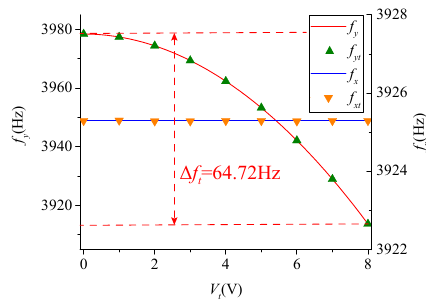
Figure 5. The effect of V t on f x and f y